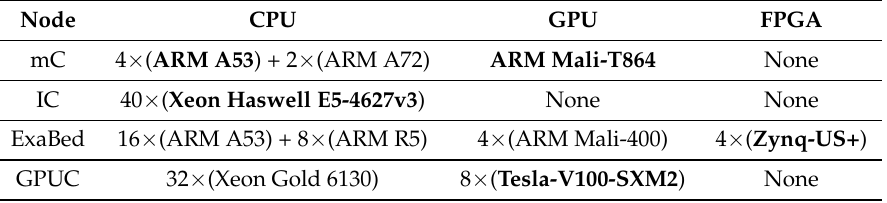
Table 1. The computing node and the associated devices. The devices exploited are highlighted in bold. Node